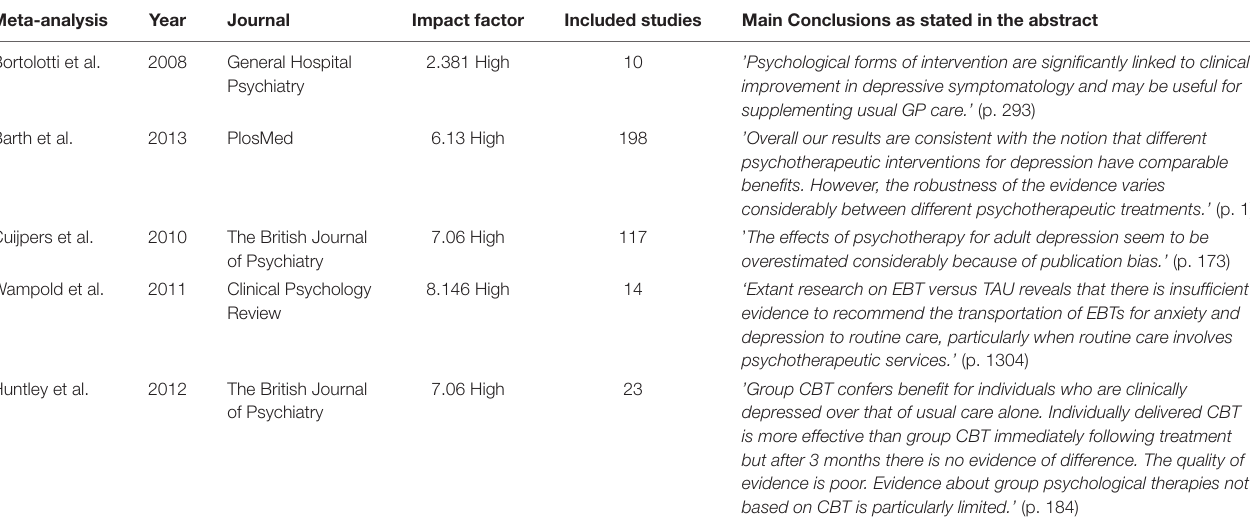
TABLE 1 | The five meta-analytic studies we analyzed in